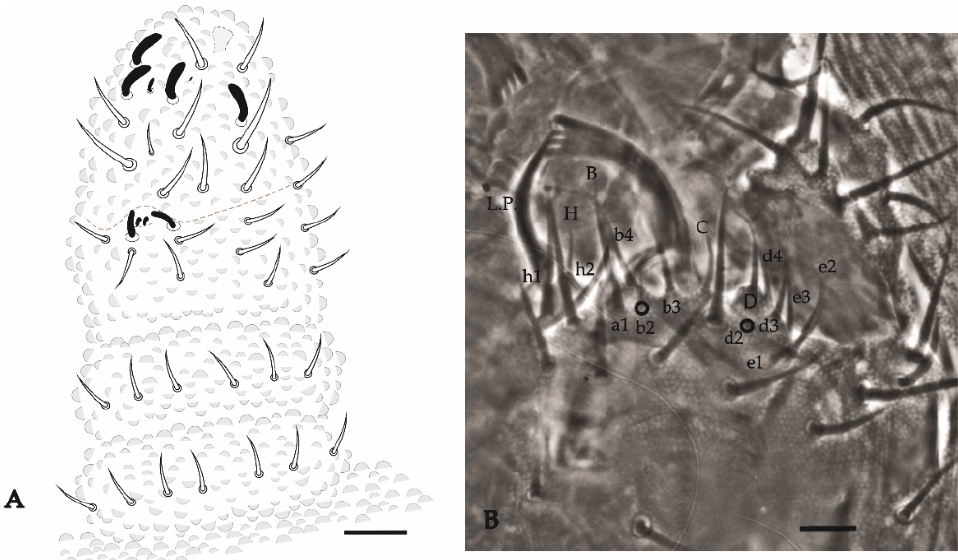
Figure 15. Paraxenylla zeliae sp. nov. ( A ), dorsal view of antenna; ( B ), labial palp and mandible apex, nomenclature after [22]. Scale bars: 10 µm.